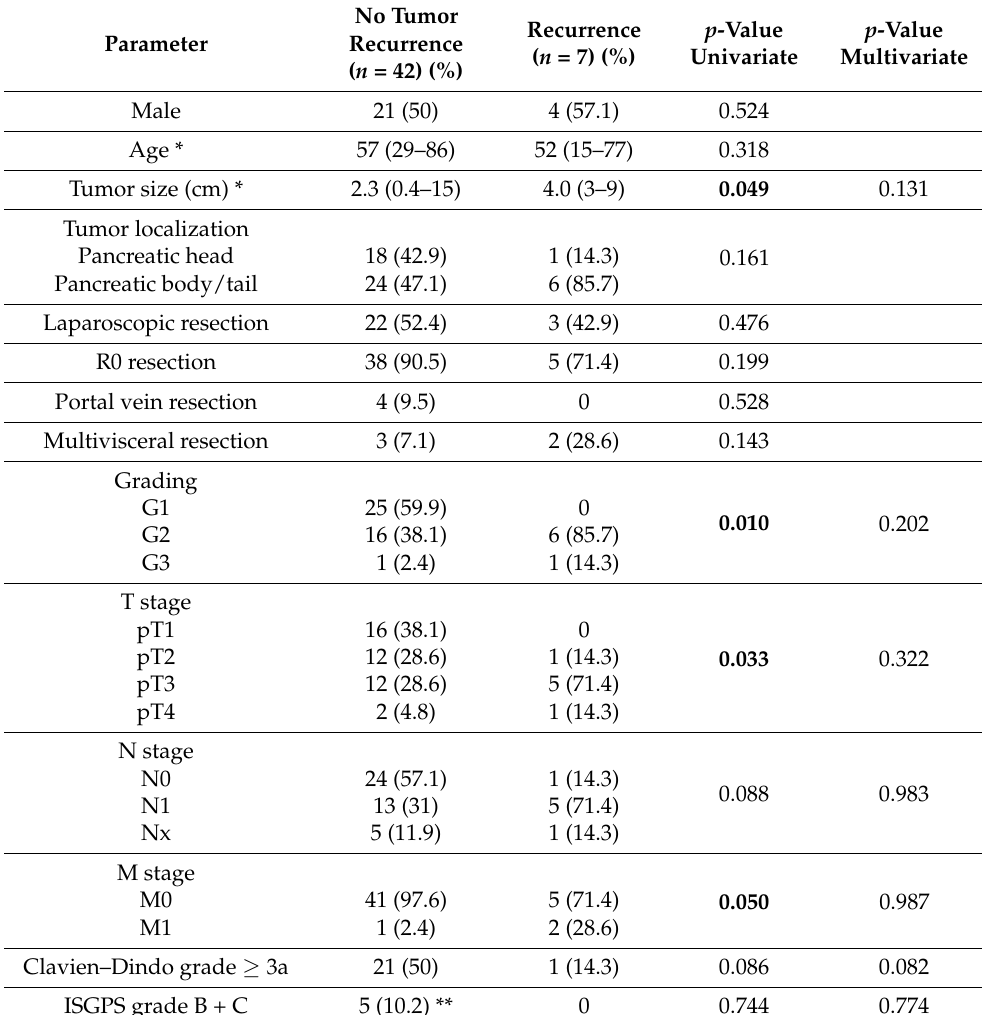
Table 3. Factors influencing the risk for tumor